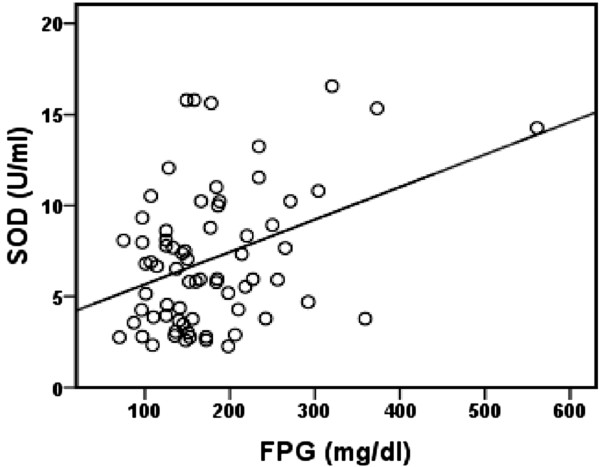
Correlation between FPG level and SOD activity in T2DM patients (r = 0.377, p = 0.001, n =70).